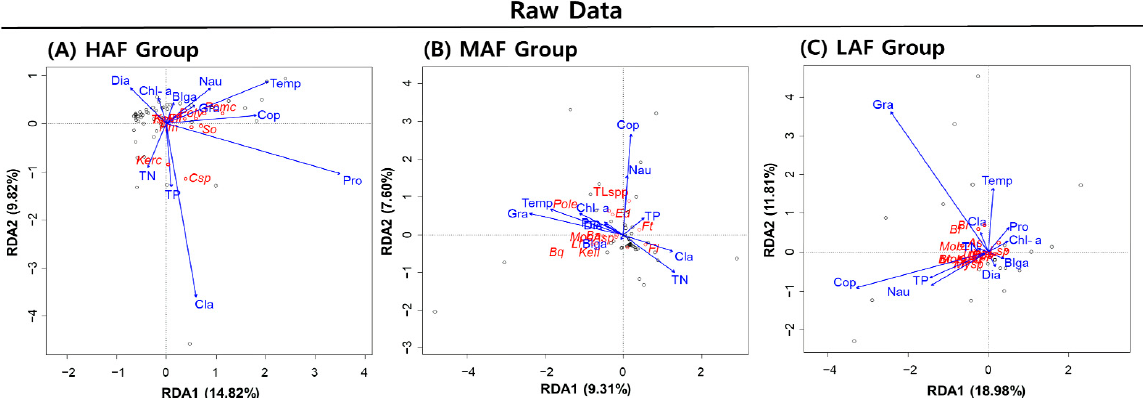
Figure 6. Redundancy analysis of the seasonal component (derived from the time series of the abun- dance estimates of three rotifer groups) and environmental factors. ( A ) High abundance and fre- quency rotifers group, ( B ) Middle abundance and frequency rotifers group, ( C ) Low abundance and frequency rotifers group.